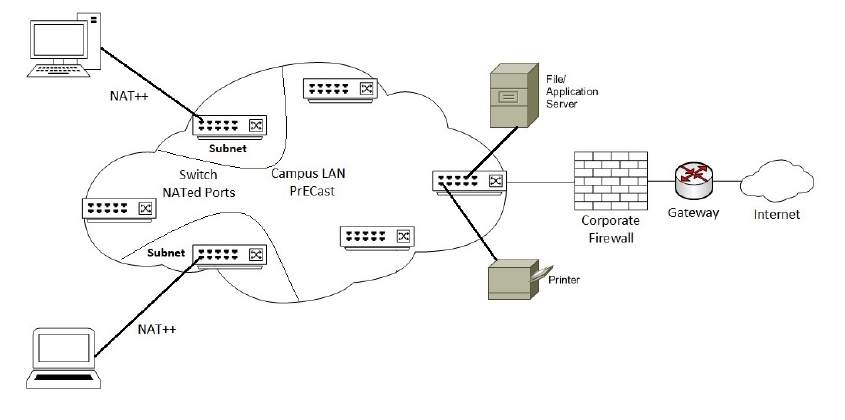
Figure 3. Integration of NAT++ with the PrECast